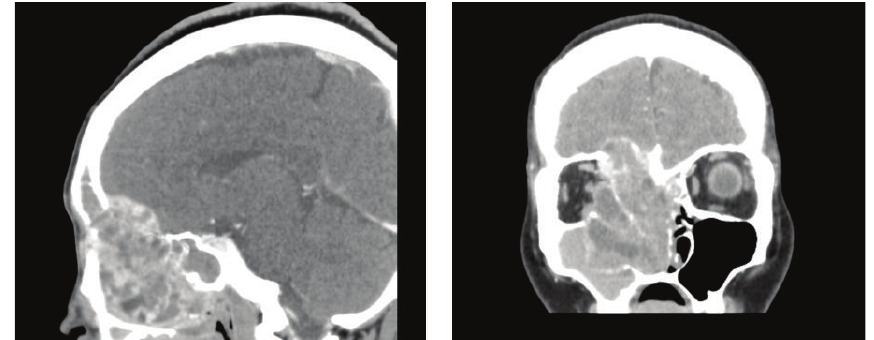
Figure 1: Preoperative computed tomography (contrast-enhanced) demonstrates the mass occupied right nasal cavity with intracranial invasion and extension into the orbit.